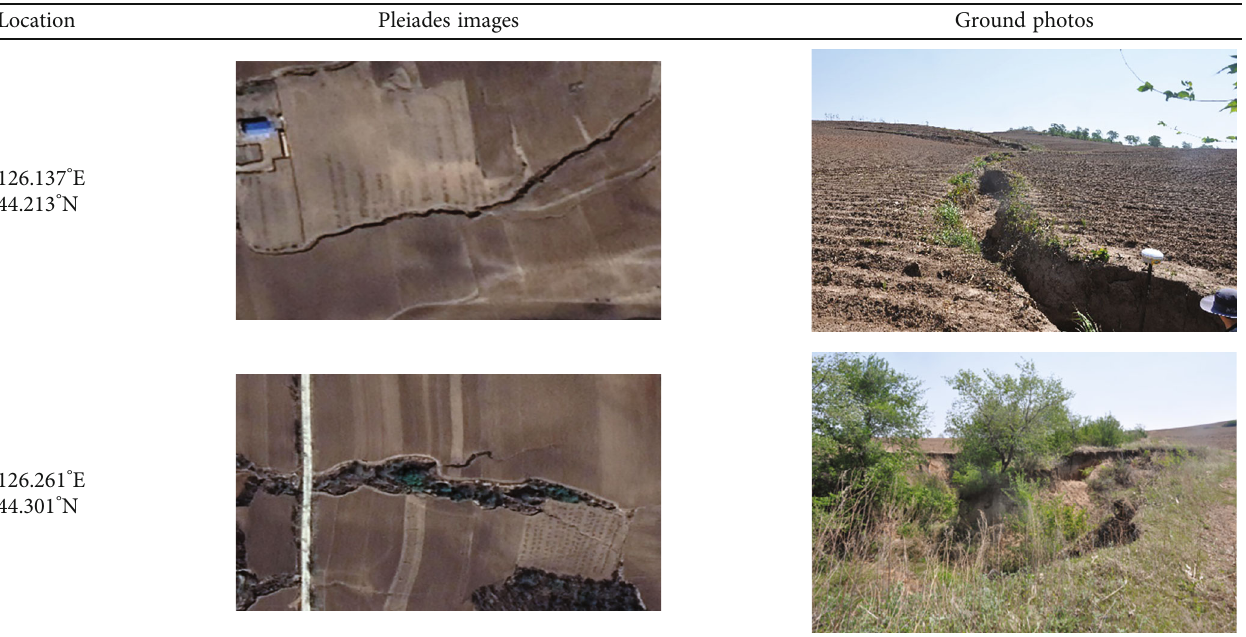
Table 2: Interpretation signs on Pleiades images.